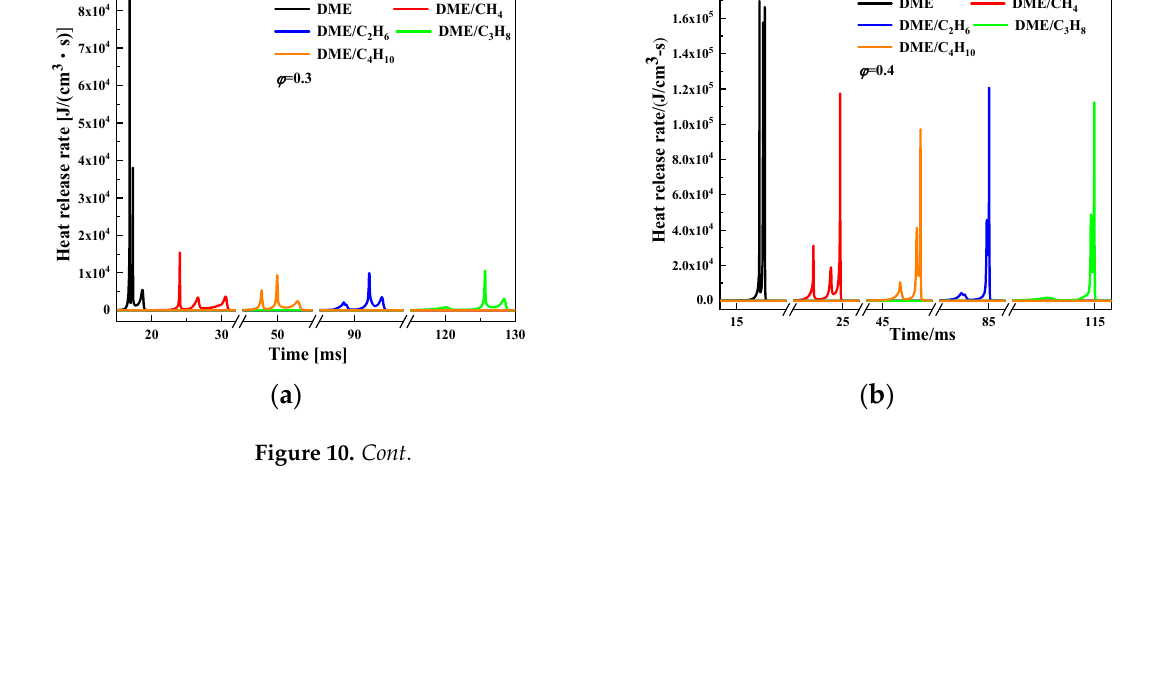
( c ) Figure 10. Comparison of heat release rate of DME/C1-C4 alkane mixtures for various equivalence ratios at T c = 650 K and P c = 20 bar: ( a ) φ = 0.3; ( b ) φ = 0.4; and ( c ) φ = 0.5.